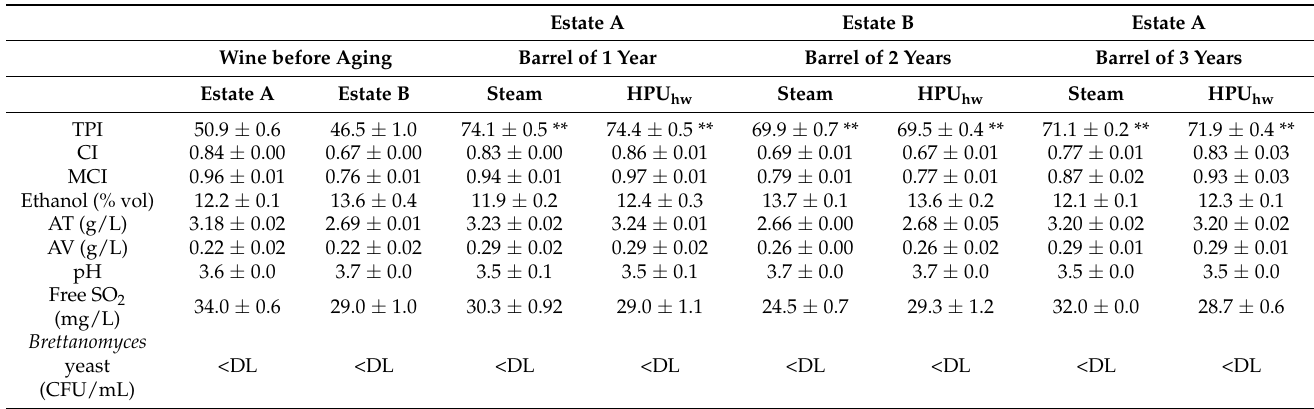
Table 1. Physicochemical and microbial properties of wines detected before and after 12 months of aging.